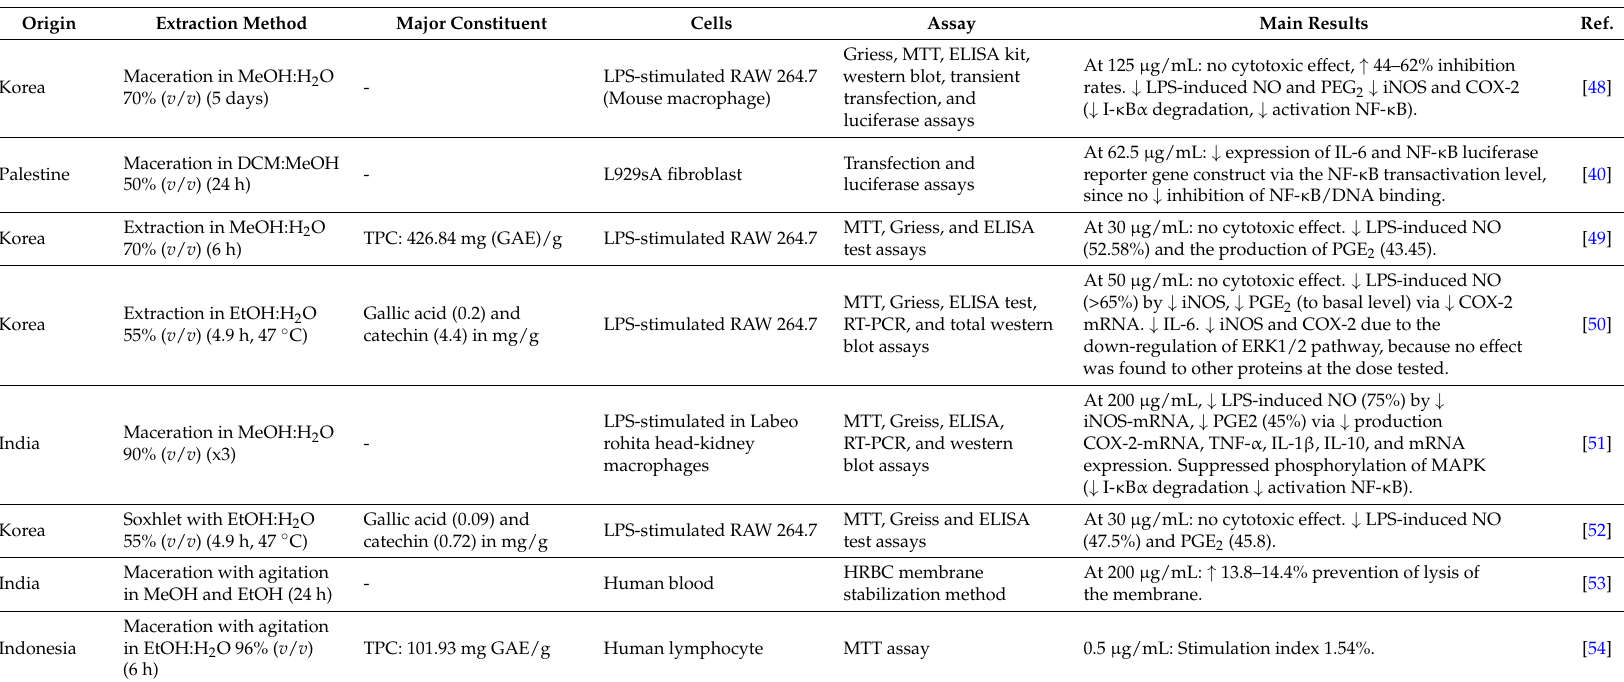
Table 3. In vitro assays against diseases of the blood and immune